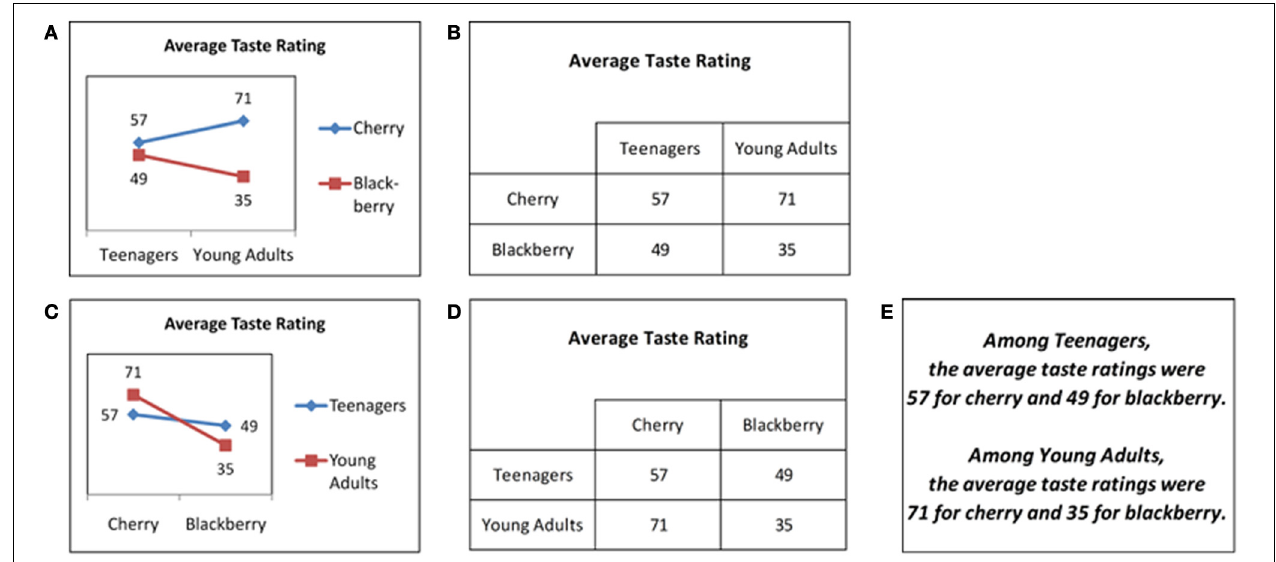
All three tasks involve relationships among data